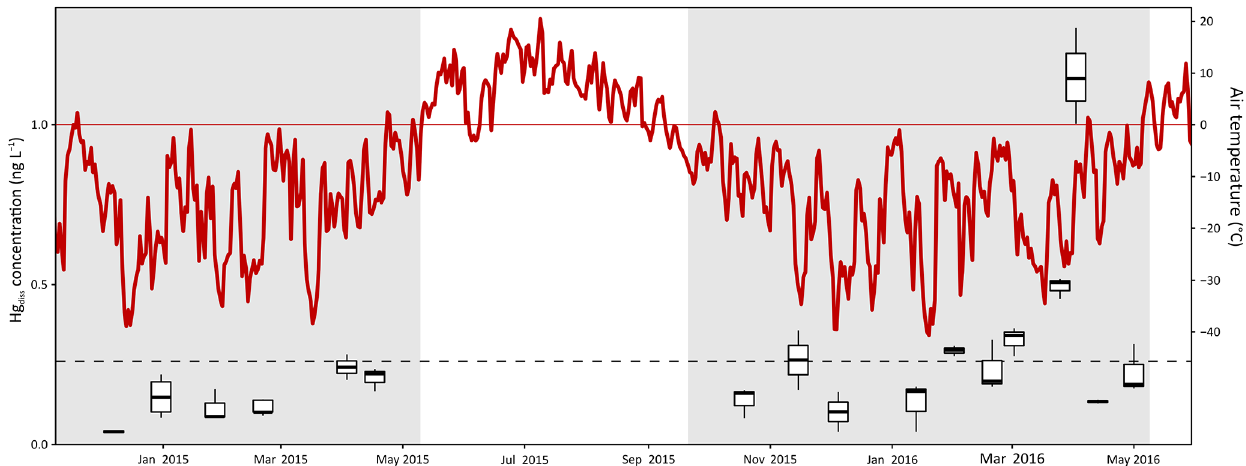
Figure 7. Temporal pattern of dissolved Hg (Hg diss ) concentrations in surface snow samples (top 3cm) throughout the 2014–2015 and 2015–2016 snow-covered seasons (in gray) at Toolik Field Station. The broken line indicates the average surface snow Hg diss concentration (0.26ngL − 1 ) . The red line indicates the daily average air